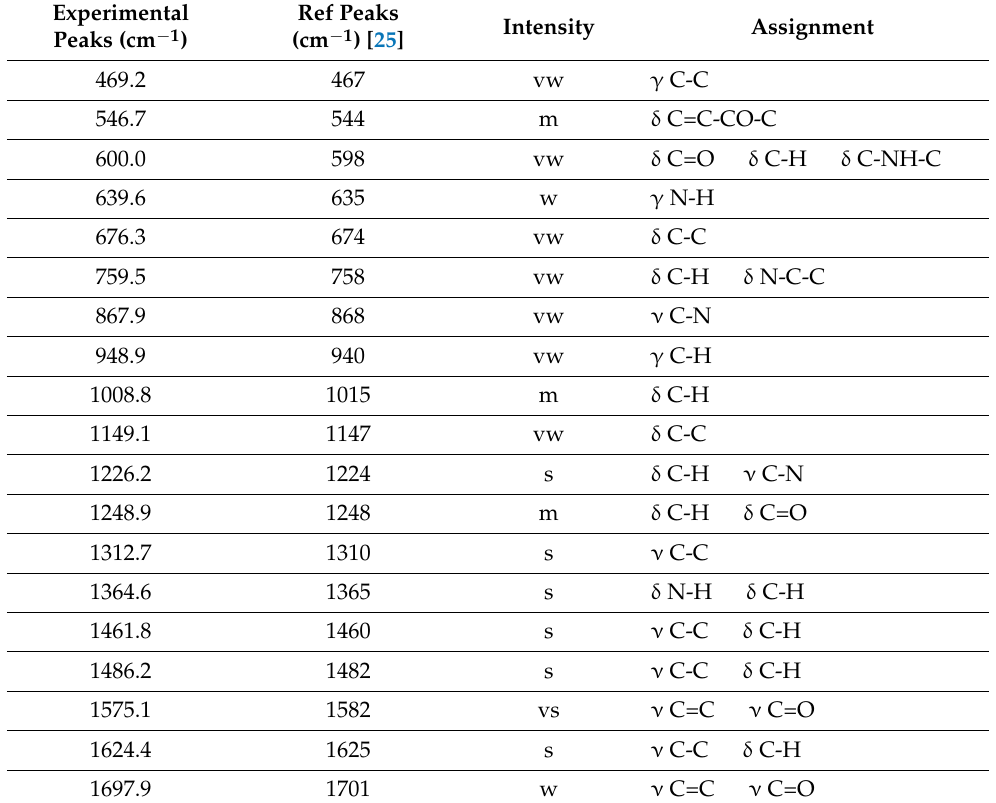
Table 1. Experimental vibrational peaks with their tentative assignments, based on literature. Legend for intensity: vw = very weak; w = weak; m = medium; s = strong; vs = very strong.